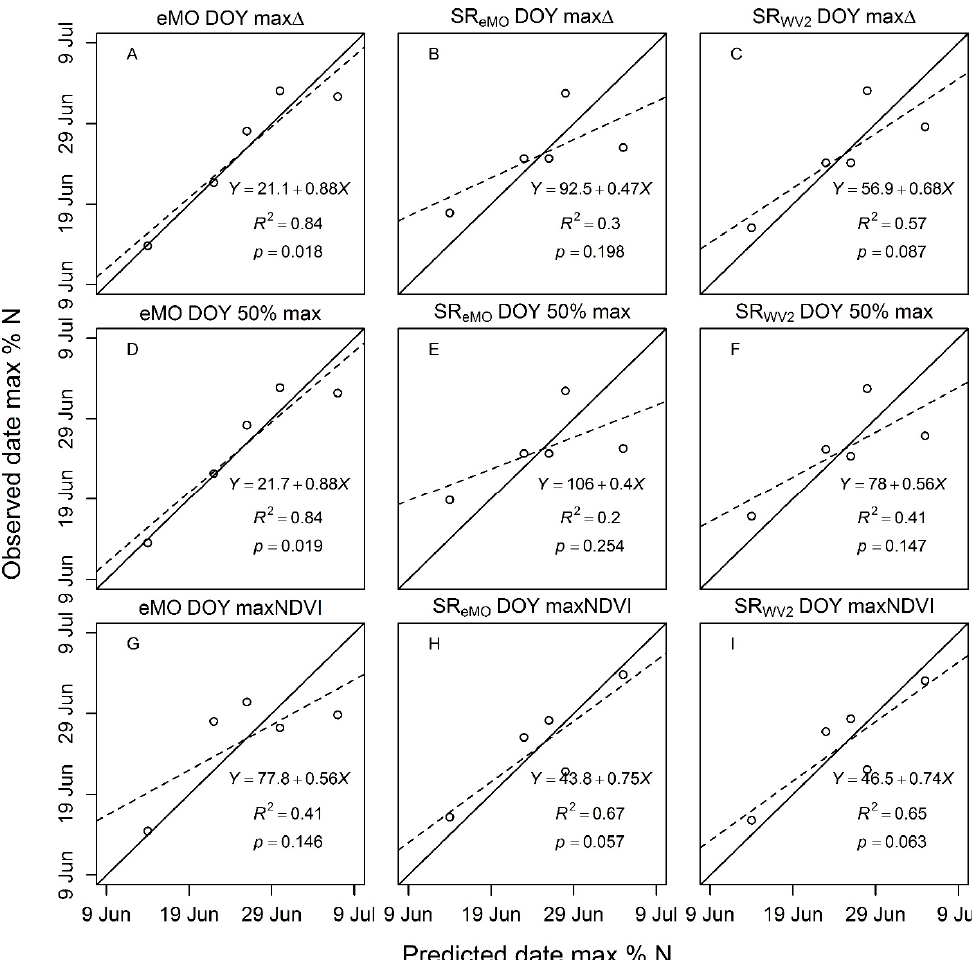
Figure 6. Comparisons of predicted and observed day of year (DOY) for peak nitrogen concentration (max %N) of halophytic graminoids across different NDVI phenology indices at the Colville River Delta, Alaska 2011–2015. NDVI phenology indices included DOY of maximum rate of change (DOY max ∆ ), half maximum (DOY 50% max), and maximum (max NDVI) and were generated from eMODIS satellite data (eMO), and handheld spectrometers with either eMODIS (SR eMO ) or Worldview2 (SR WV2 ) band definitions. DOY of peak nitrogen was estimated by fitting 3rd-order polynomials to seasonal percent nitrogen measurements. Percent nitrogen predictions were generated from linear regression models of the general form (date peak vegetation %N ~ β 0 + β 1 x NDVI phenology index). Solid lines indicate a perfect 1:1 relationship, and dashed lines show the best fit lines from regression of predicted = β 0 + β 1 x observed. Dates are representative of non-leap years (i.e., 2011, 2013–2015).